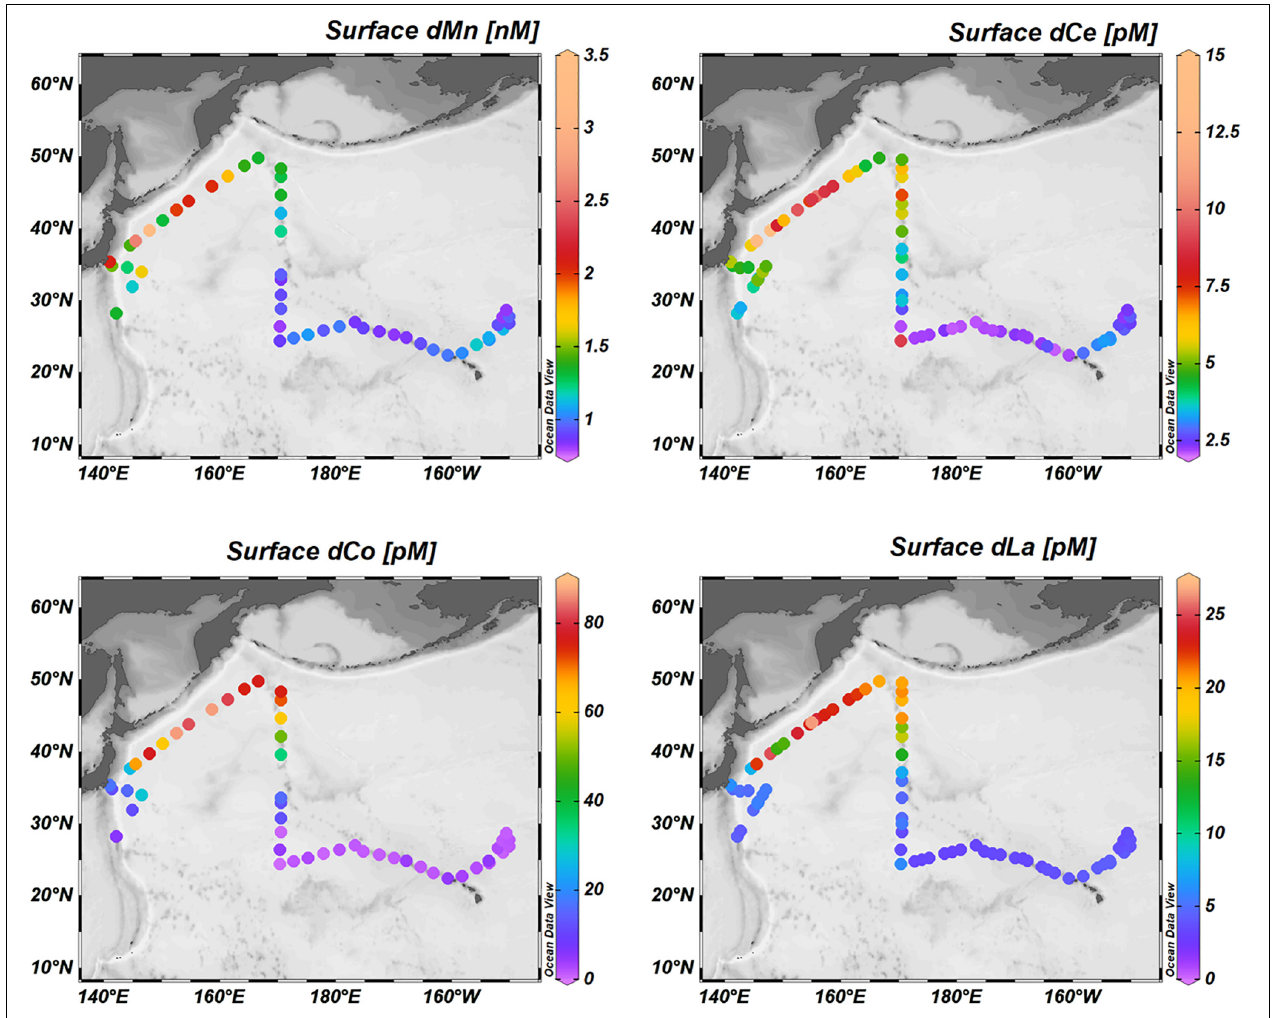
FIGURE 4 | Surface distributions of dissolved trace elements: surface distributions of dissolved Mn, Ce, Co, and